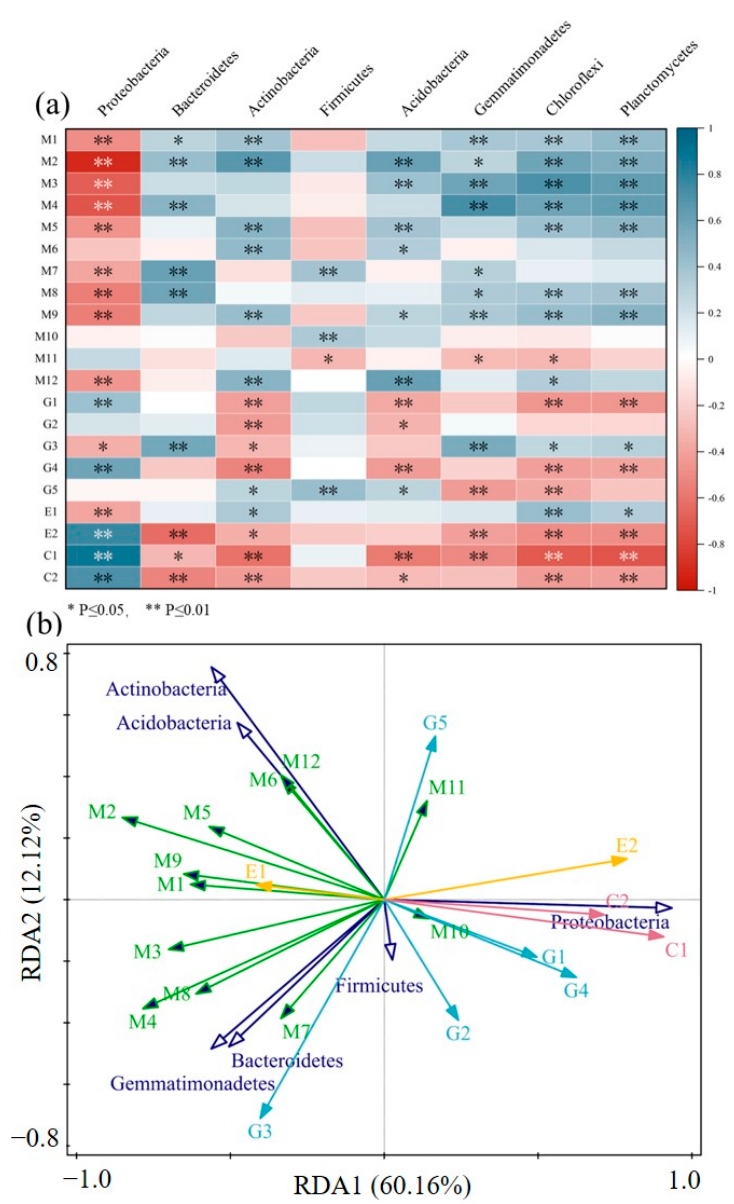
Figure 4. The Relationship between relative abundances of bacterial major secondary metabolic pathways and bacterial phyla ( a ): correlation analysis; ( b ): RDA analysis. M1: amino acid metabolism; M2: carbohydrate metabolism; M3: energy metabolism; M4: metabolism of cofactors and